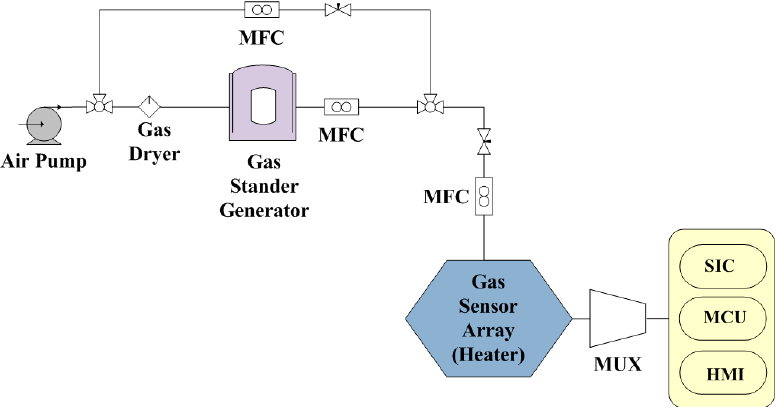
Figure 7. Experimental setup of the gas sensing system.